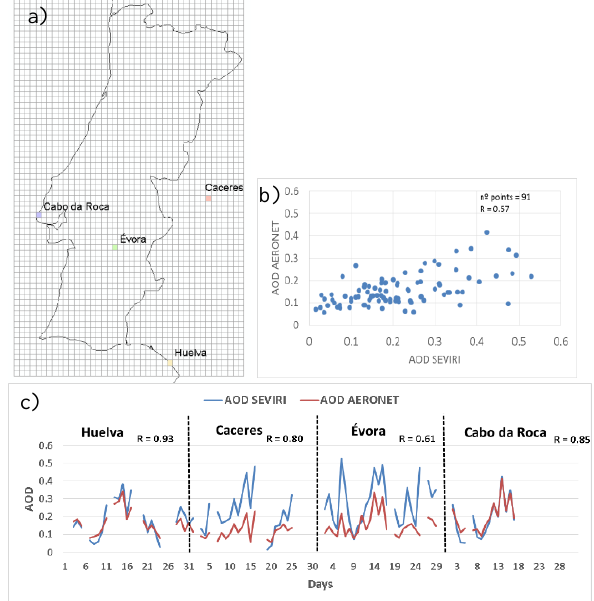
Figure 4. a) Localition of AERONET Stations, b) Scatterplot of daily mean AOD values from AERONET versus SEVIRI and c) trendlines of the daily mean AOD value from AERONET and SEVIRI for May